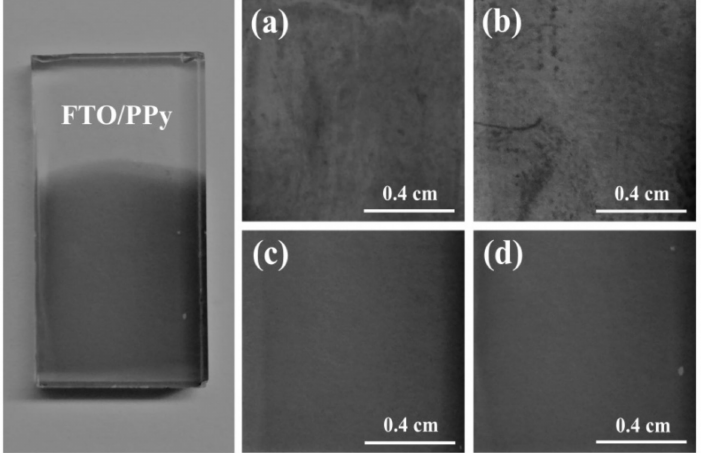
Figure 5. Photos of polypyrrole films synthesized at: ( a ) 0.9 V, ( b ) 1.0 V, ( c ) 1.1 V, and ( d ) 1.2 V (vs. Ag/AgCl). Synthesis solution (0.25 M pyrrole and 0.5 M LiClO 4 in acetonitrile +2% w / w H 2 O). In all cases, the electric charge supplied was 10 mC/cm 2 . The complete photo shows PPy on FTO synthesized at 1.2